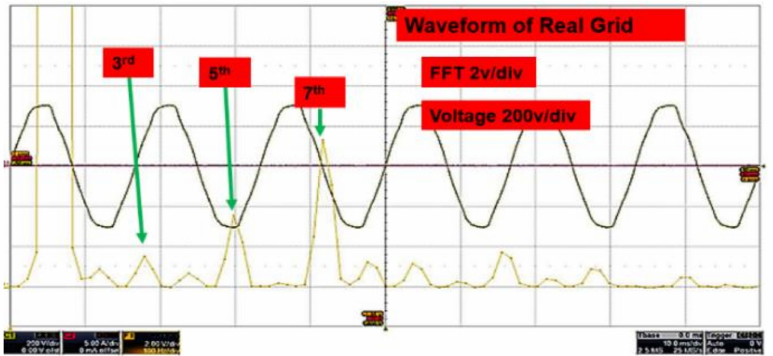
Figure 12. Grid voltage and its FFT result (2%